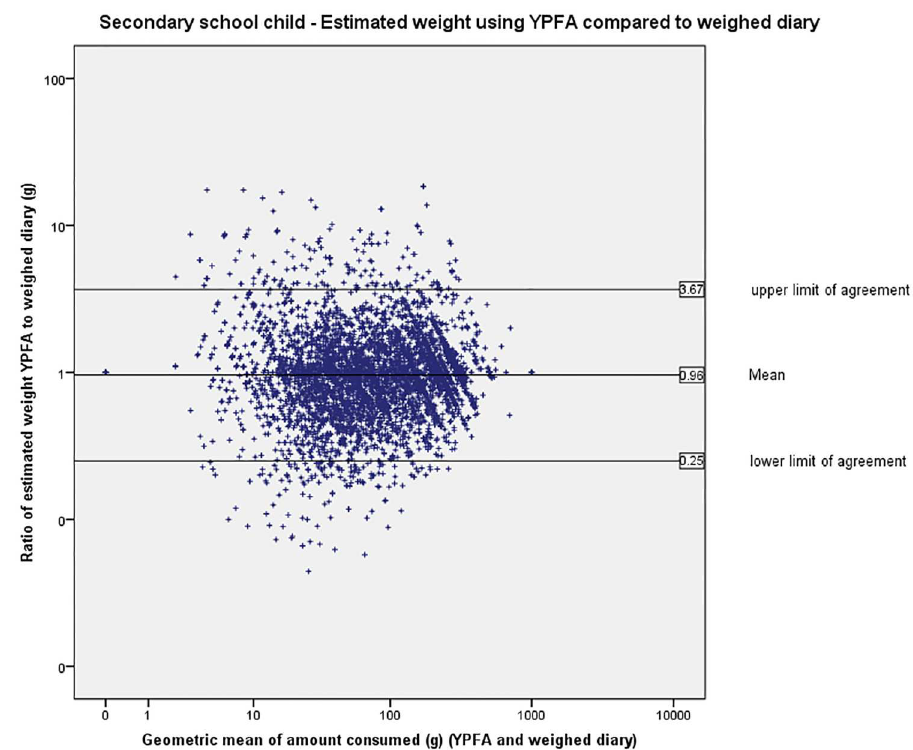
Fig 6. Secondary school children—Bland-Altman plot showing estimated weight using YPFA compared to weighed